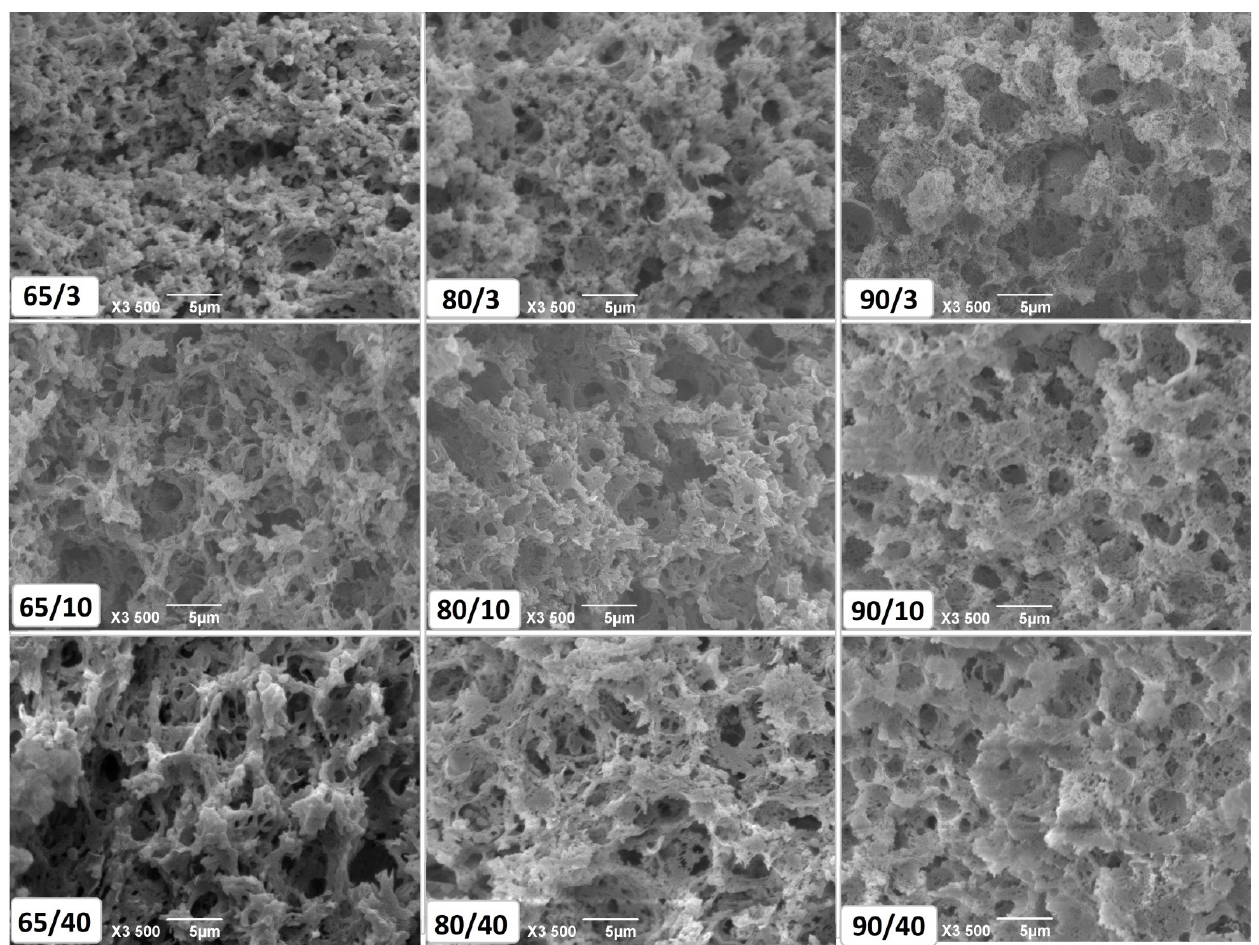
Figure 3. Microstructure of goat cheeses produced from milk heated to 65 °C/30 min, 80 °C/5 min and 90 °C/5 min, in the early (3 days) ripening stage (65/3, 80/3 and 90/3), mid (10 days) ripening stage (65/10, 80/10 and 90/10) and late (40 days) ripening stage (65/40, 80/40 and 90/40).